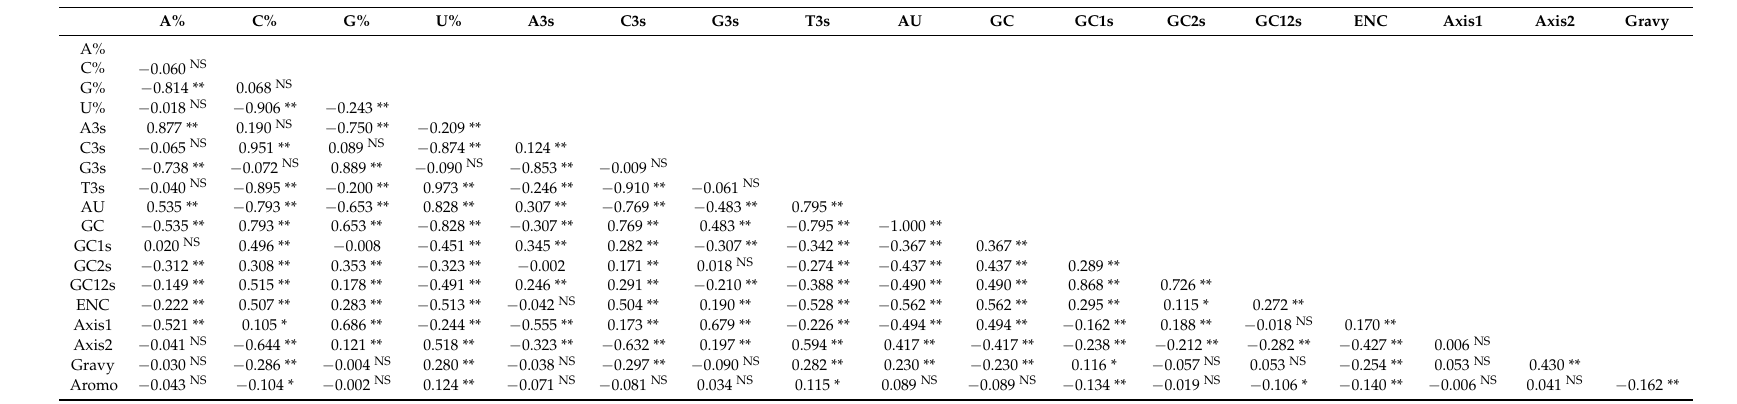
Table 2. Correlation analysis of RABV genome coding